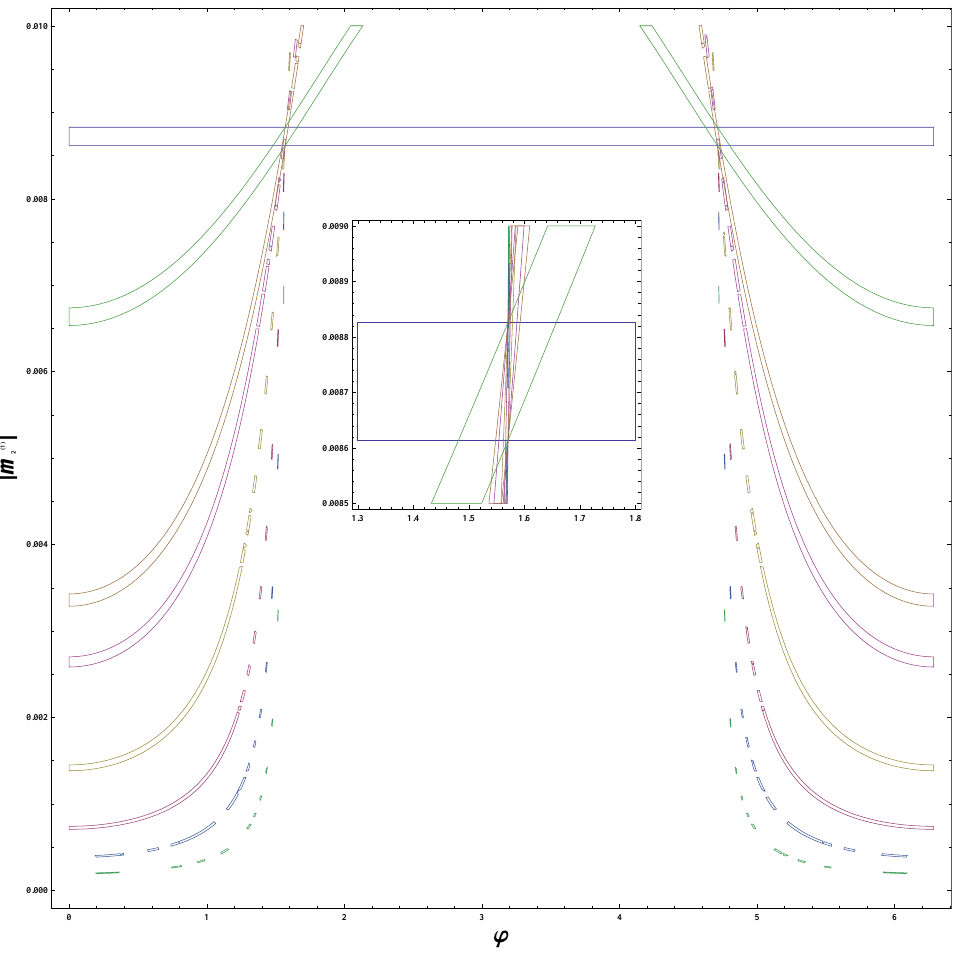
Figure 3. In this figure, the contour plot of Figure 2, the entire region of the | m allowed range of m 0 are shown. In the zoomed box we have magnified the right overlap